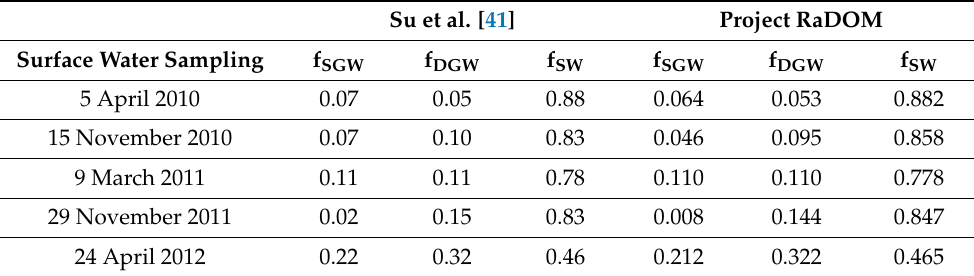
Table 3. Comparison of results of original mixing model from Su et al. [41] and Project RaDOM models using the same data. f SGW is the fraction from shallow groundwater, f DGW is the fraction from deep groundwater, and f SW is the fraction of sea water. Reprinted/adapted with permission from Ref. [41]. 2013, Springer Nature. Su et al.